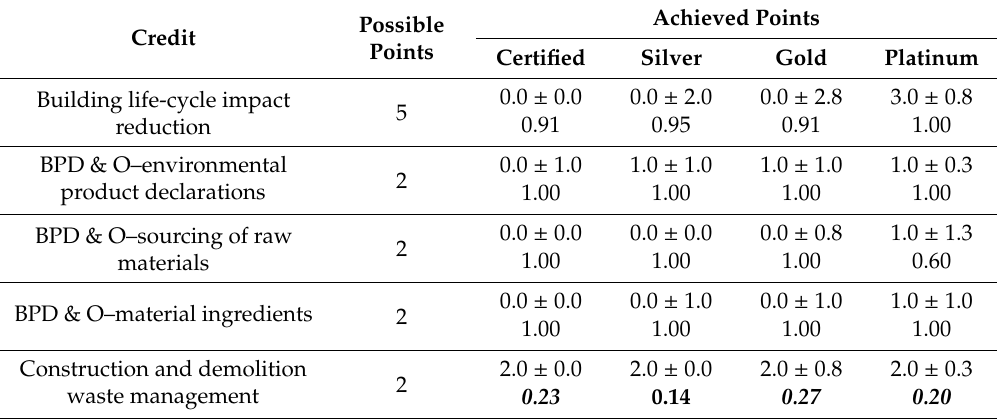
Figure 6. The boxplot results and Cliff’s δ effect size between possible and achieved points in the Materials and Resources (MR) category. Effect size is considered to be: very high if | δ | < 0.147 (bold font), high if 0.147 < | δ | < 0.33 (bold italic font), medium if 0.33 < | δ | < 0.474 (italic font), and low if | δ | ≥ 0.474 (normal font). Table 6. Credit points achieved for Materials and Resources category of LEED-NCv4 projects: median